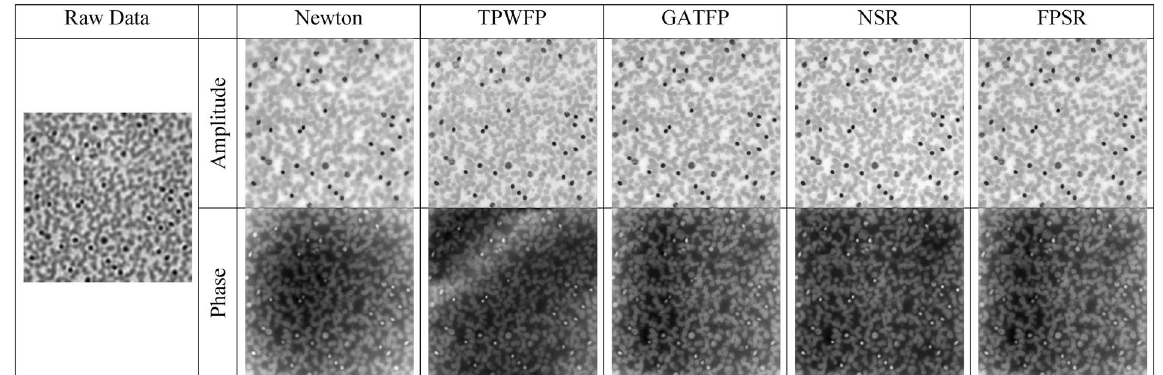
Figure 3. Reconstruction results over Blood smear using different algorithms (Newton method, TPWFP, GATFP, NSR and